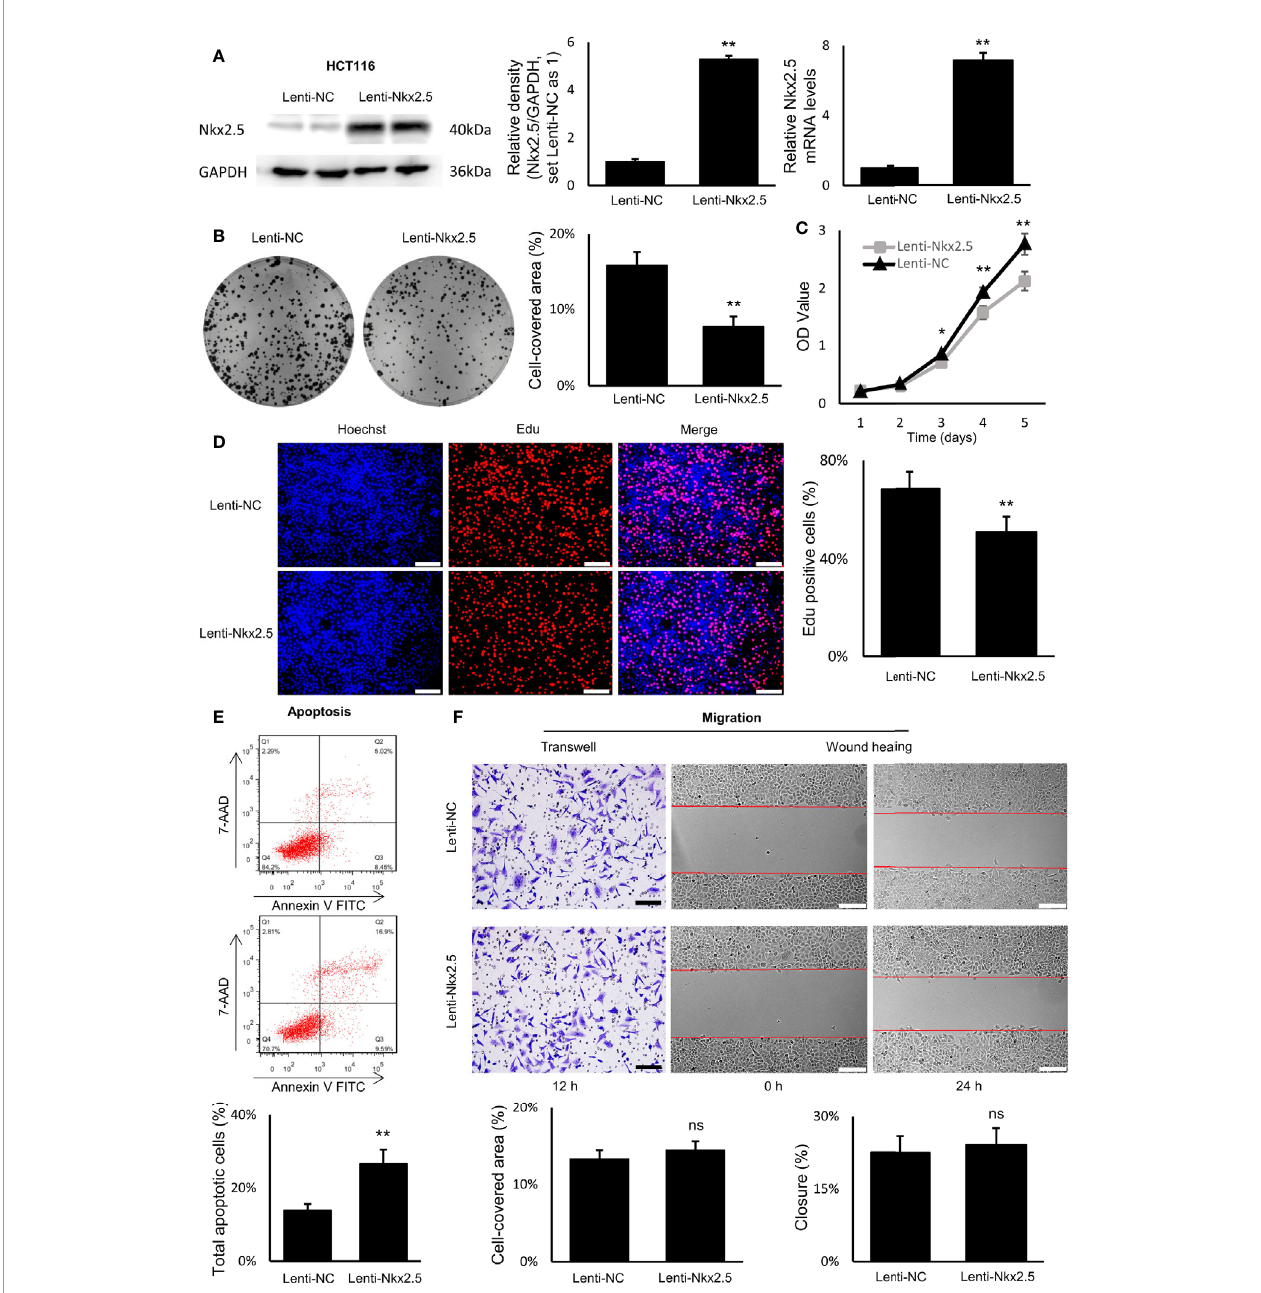
FIGURE 3 | Nkx2.5 could suppress proliferation and induce apoptosis in cultured HCT116 cells. (A) Detection of the protein and mRNA levels of Nkx2.5 in Lenti-NC and Lenti-Nkx2.5 HCT116 cells by Western blotting and RT-qPCR. GAPDH was used as an endogenous control gene. (B) Representative photographs of colony formation of the Lenti-NC and Lenti-Nkx2.5 HCT116 cells. Cell-covered area of colonies was quanti fi ed and shown as percentage (%) relative to area of the well bottom. (C) Cell growth of the Lenti-NC and Lenti-Nkx2.5 HCT116 cells was determined by MTT assay at each time-point. (D) Representative pro fi les of EdU cell proliferation assay in the Lenti-NC and Lenti-Nkx2.5 HCT116 cells. Representative photographs were taken at magni fi cation of 200×. Scale bar (white) is 100- m m. (E) Apoptosis of Lenti-NC and Lenti-Nkx2.5 HCT116 cells was measured by fl ow cytometry. Representative histograms show cell population in apoptotic (top right and bottom right quadrants), viable (bottom left quadrant), and necrotic (top left quadrant) states. (F) Cell migration was assessed by Transwell ® assay and wound-healing assay. Representative photographs were taken at magni fi cations of 200× and 100× for Transwell ® assay and wound-healing assay, respectively. Scale bar (black) is 100- m m. Scale bar (white) is 200- m m. * represents P < 0.05; ** represents P < 0.01; ns represents P ≥ 0.05 (no statistical signi fi